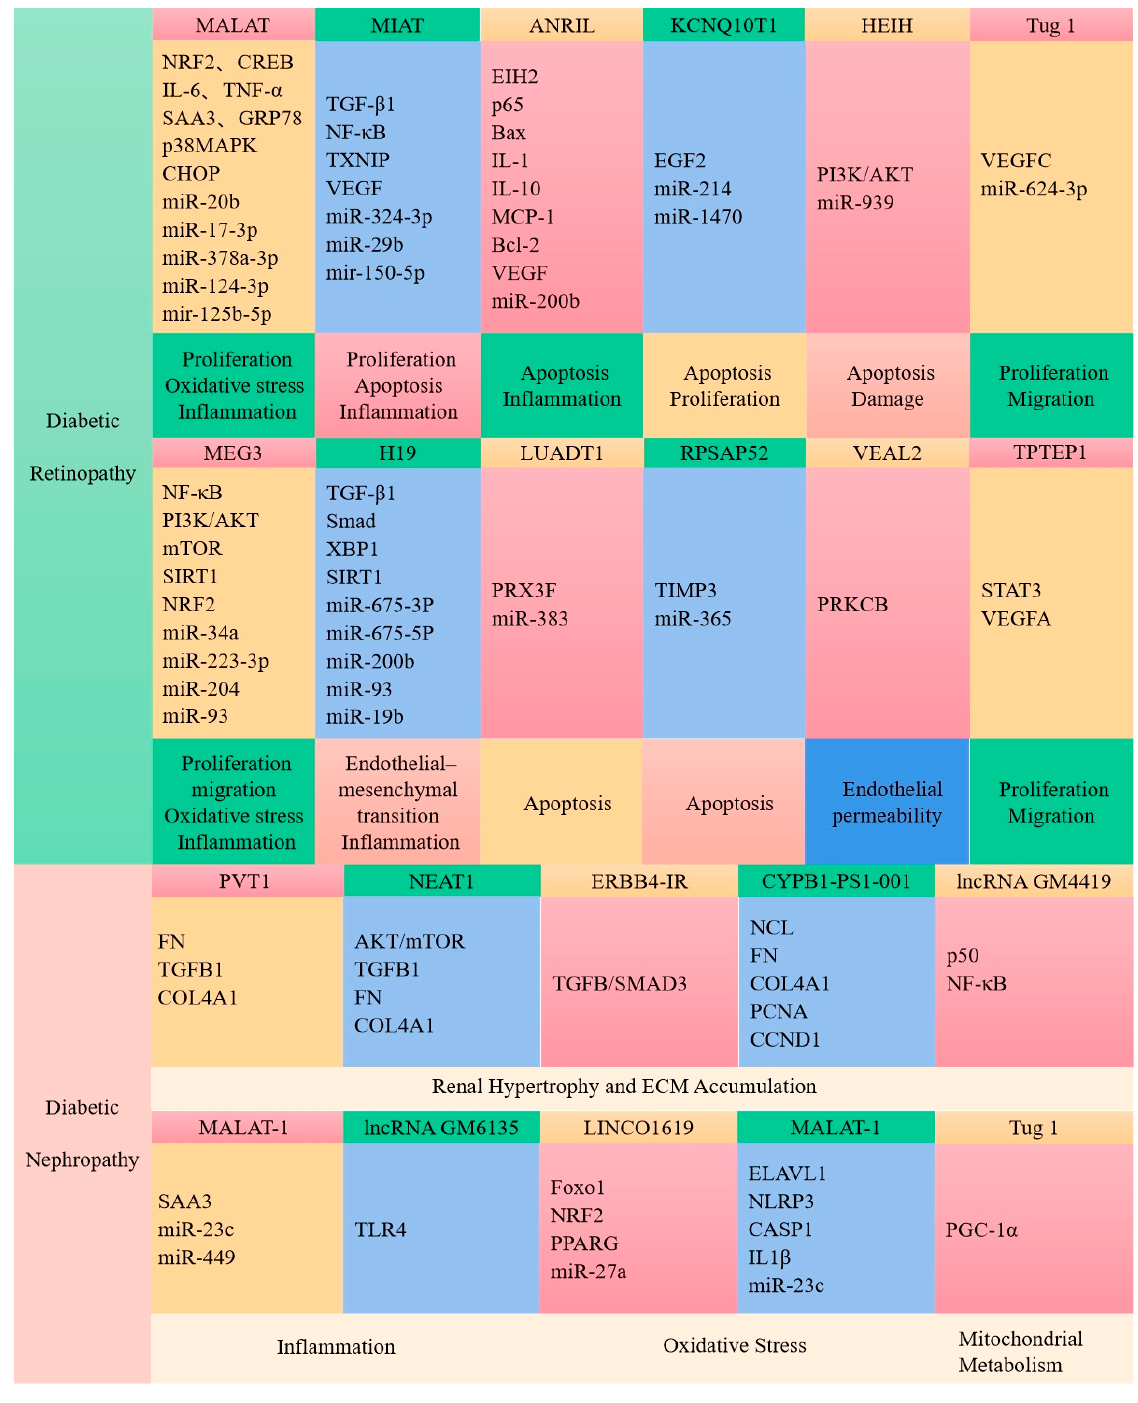
Figure 2. LncRNAs are closely associated with the development of diabetic